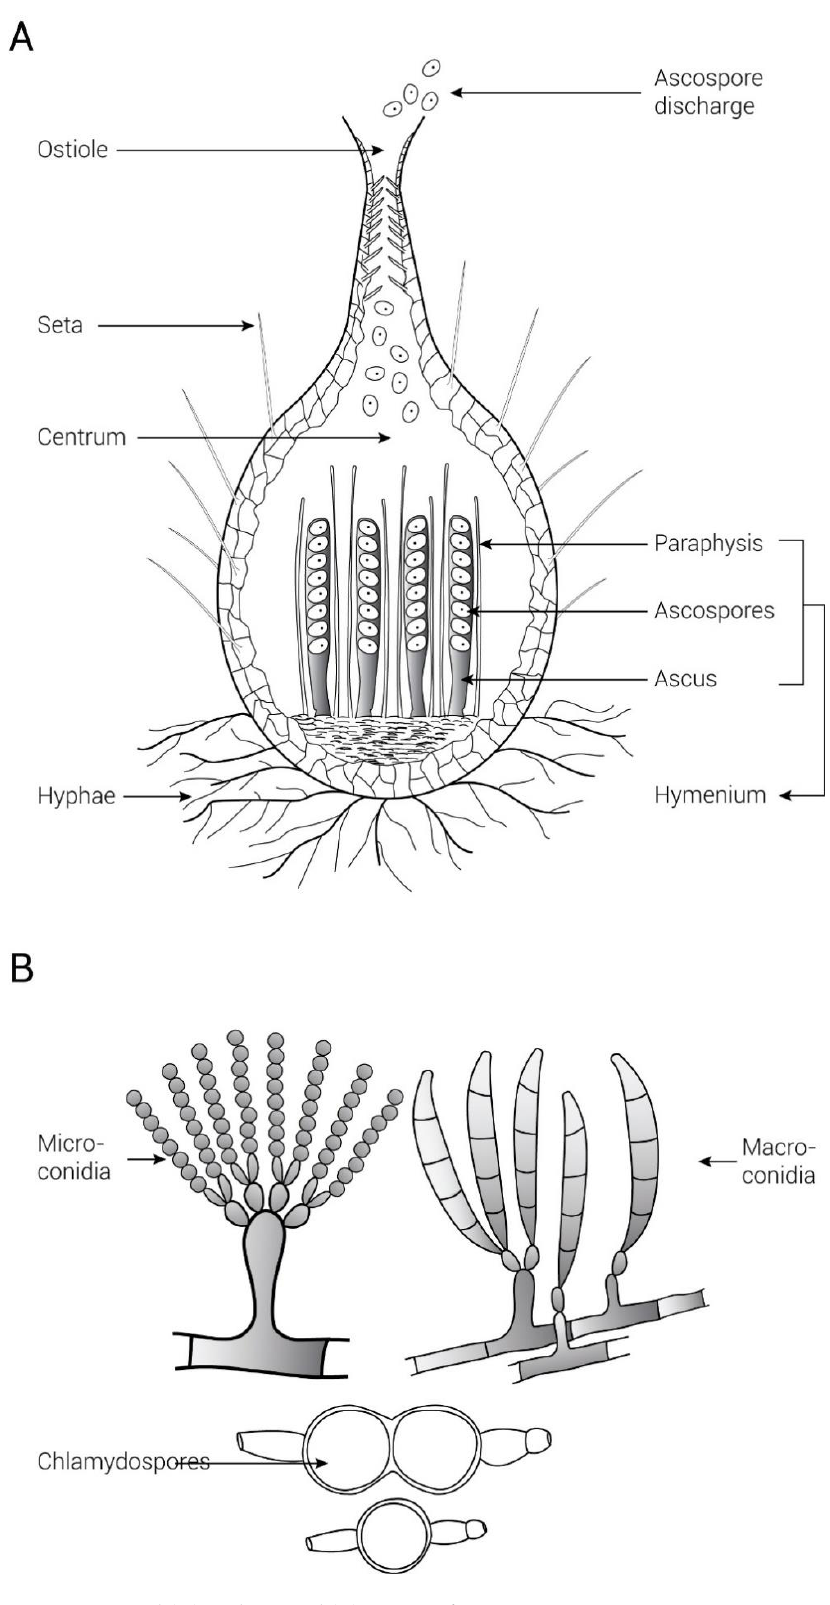
Figure 1. Sexual ( A ) and asexual ( B ) spores of Fusarium .